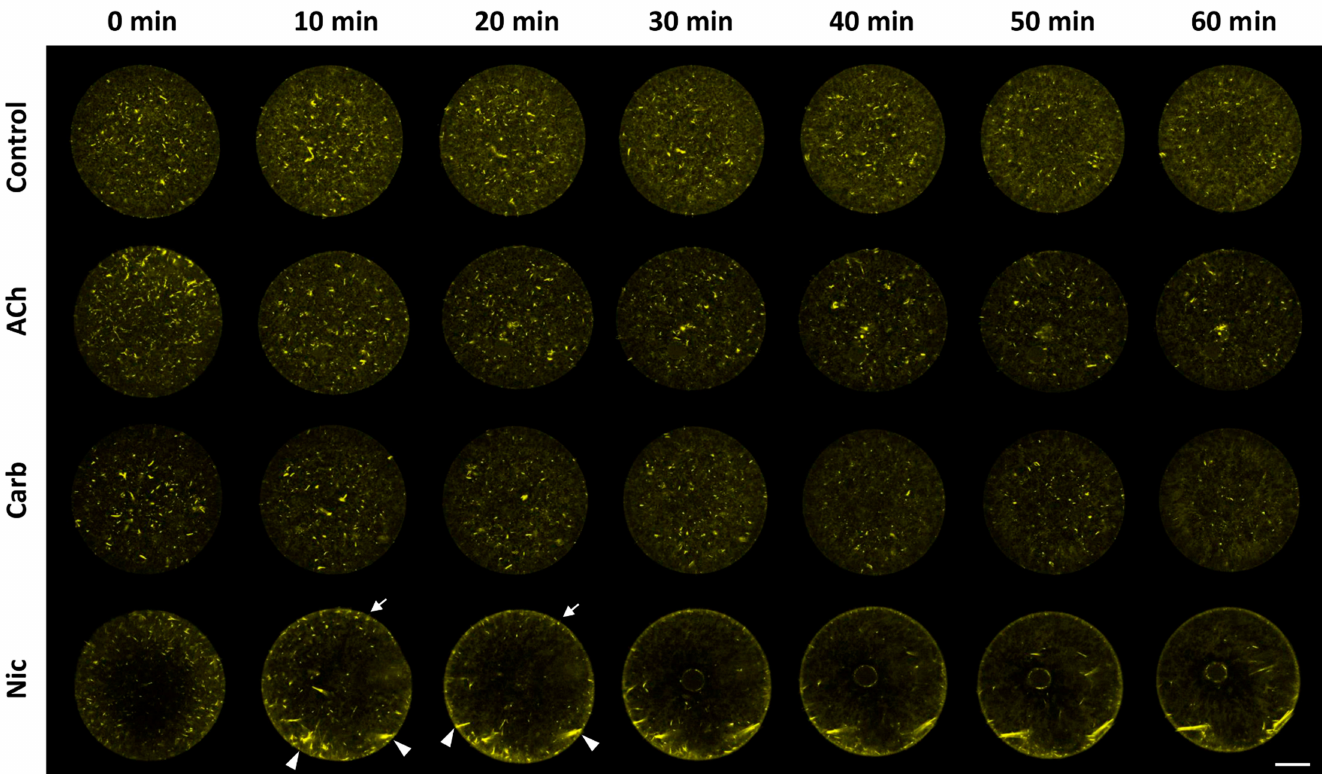
Figure 8. E ff ects of microinjected ACh, carbachol and nicotine on cortical F-actin of sea urchin eggs. P. lividus eggs were microinjected with Alexa-Phalloidin (10 µ M, pipette concentration). After 15 min, the eggs were microinjected again with ACh or carbachol (1 mM, pipette concentration), and the changes of the actin filament in the same living eggs were monitored by confocal microscopy at 10 min intervals. The confocal images immediately before the second microinjection were considered as t = 0 min. For comparison, the second microinjection of some eggs was made with 1 mM (pipette concentration) of ( − )nicotine, or with distilled water (negative control). Please note that only in the eggs microinjected with nicotine, the subplasmalemmal F-actin evidently started to get hyperpolymerized by 10–20 min (arrows) or to form thick F-actin bundles (arrowheads). Scale bar = 20 µ m. Each image represents similar results obtained from 4–5 eggs in the given